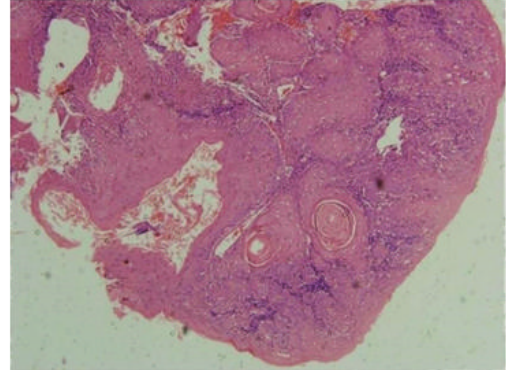
Figure 7: Cytological smear from left submandibular lymph node showing squamous dysplastic islands suggestive of squamous cell